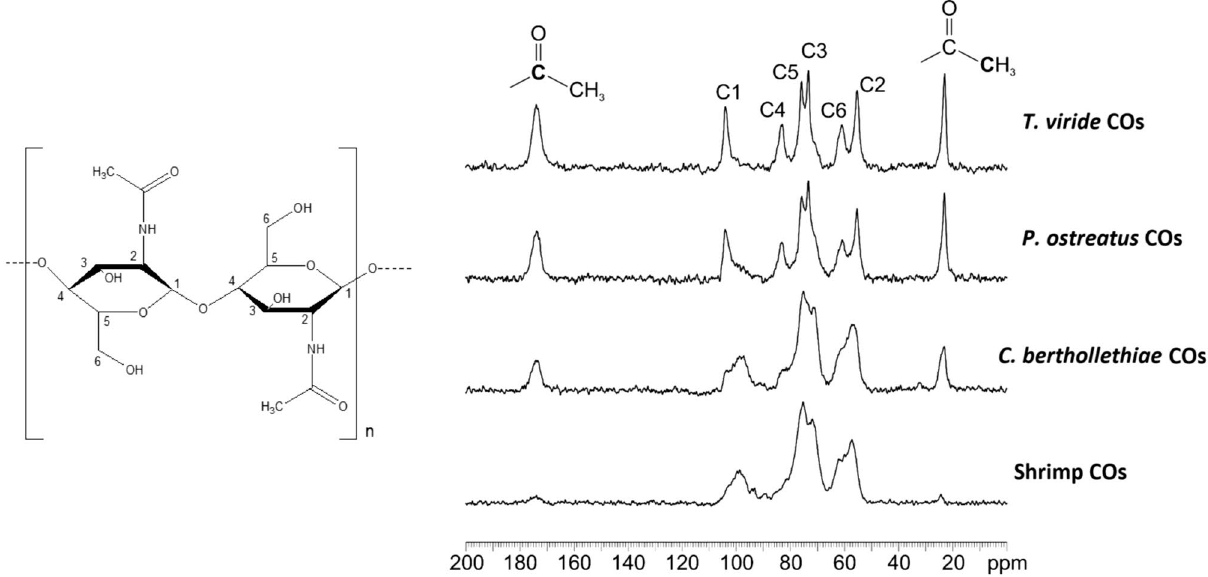
Figure 1. 13 C CPMAS SSNMR spectra of chitooligosaccharides from T. viride , P. ostreatus , C. bertholletiae and shrimps, acquired at room temperature at a spinning speed of 20 kHz. The labels of carbon atoms (C1-C6) refer to the scheme on the left. The spectra indicate that the four samples are characterized by different degrees of acetylation; in particular, this is lowest in shrimp-derived COs and highest in T. viride- derived acetic acid (see “Methods” section). Figure 2 and Supplementary Fig. S4 display the 1 H spectra of the analyzed